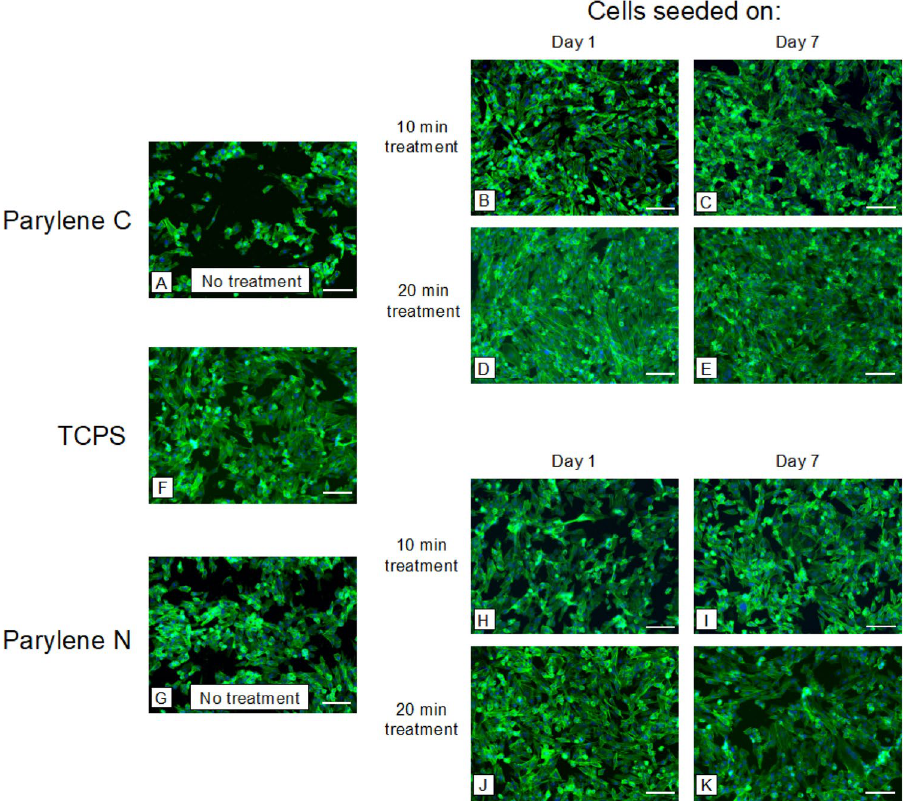
Figure 1. Spreading of vascular endothelial cells (HUVECs) on plasma-treated and untreated samples. Samples were treated for either 10 or 20 min of oxygen plasma, and cells were seeded on the substrates on day 1 or day 7 to investigate the effect of plasma treatment and its persistence. Representative images of nuclei (DAPI, blue) and F-actin (phalloidin, green) after 24 h on ( A–E ) Parylene C membranes, ( F ) TCPS, and ( G–K ) Parylene N membranes. Scale bar = 100 μm in all